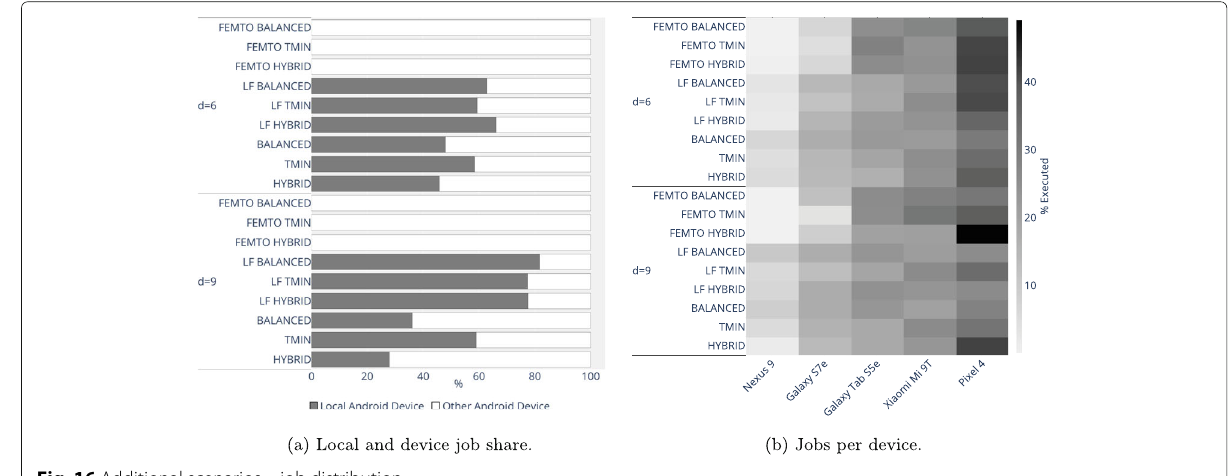
Fig. 16 Additional scenarios – job